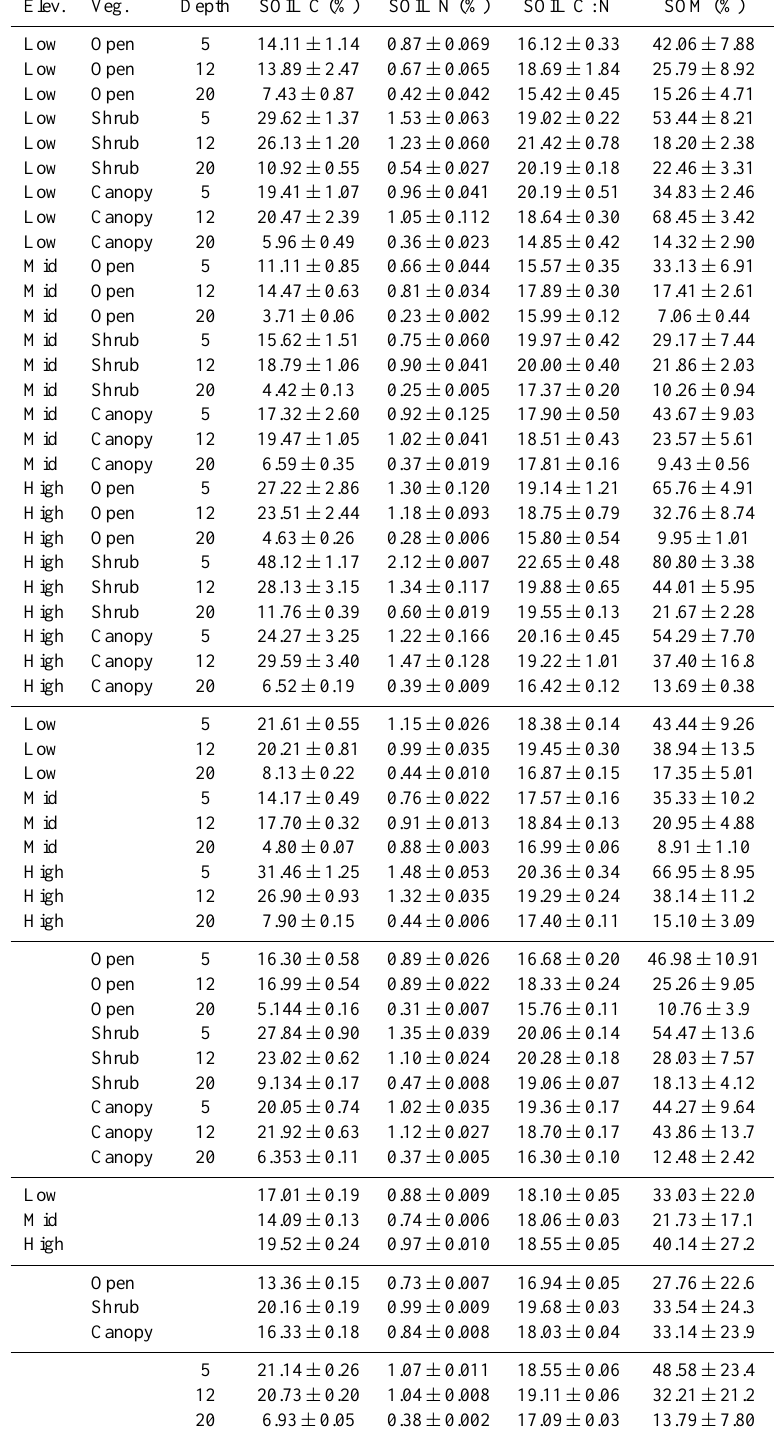
Table D1. Total soil carbon (%), total soil nitrogen (%), total soil C:N ratio, and soil organic matter (SOM; %) with all combinations of elevation, vegetation, depth levels, and